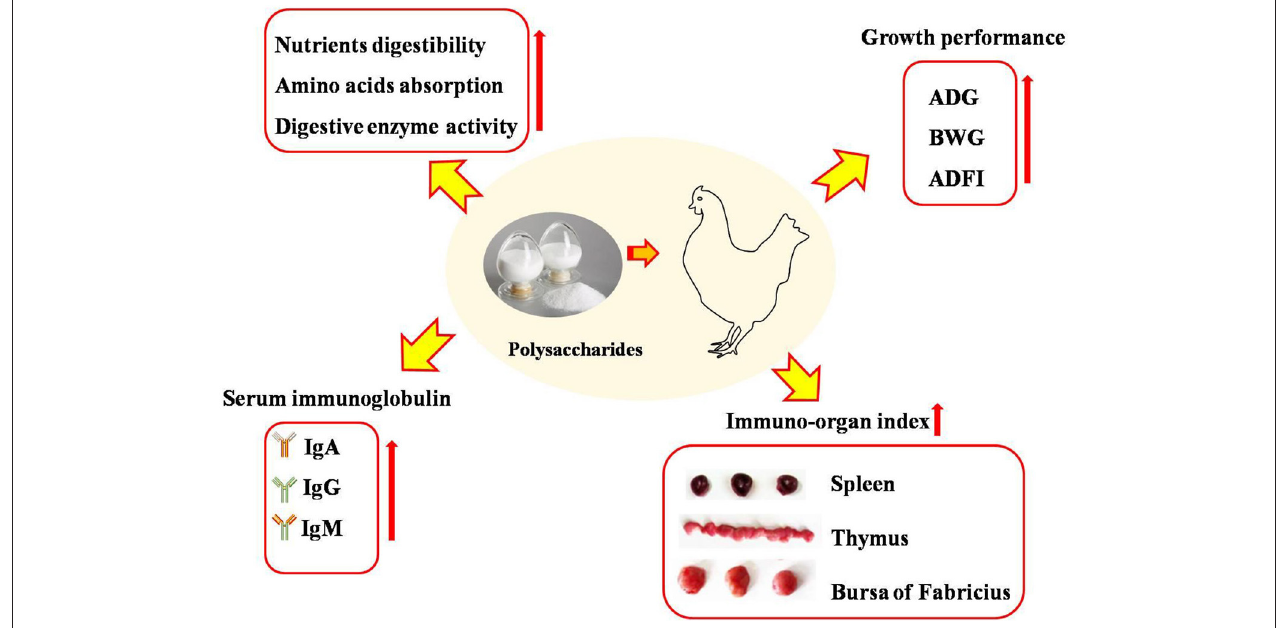
FIGURE 1 | Dietary polysaccharides supplementation improved growth performance, increased nutrients digestibility and amino acids absorption, elevated the content of serum immunoglobulin and immune-ogran index of broilers. IgA, immunoglobulin A; IgG, immunoglobulin G; IgM, immunoglobulin M; ADG, average daily weight gain; BWG, body weight gain; ADFI, average daily feed